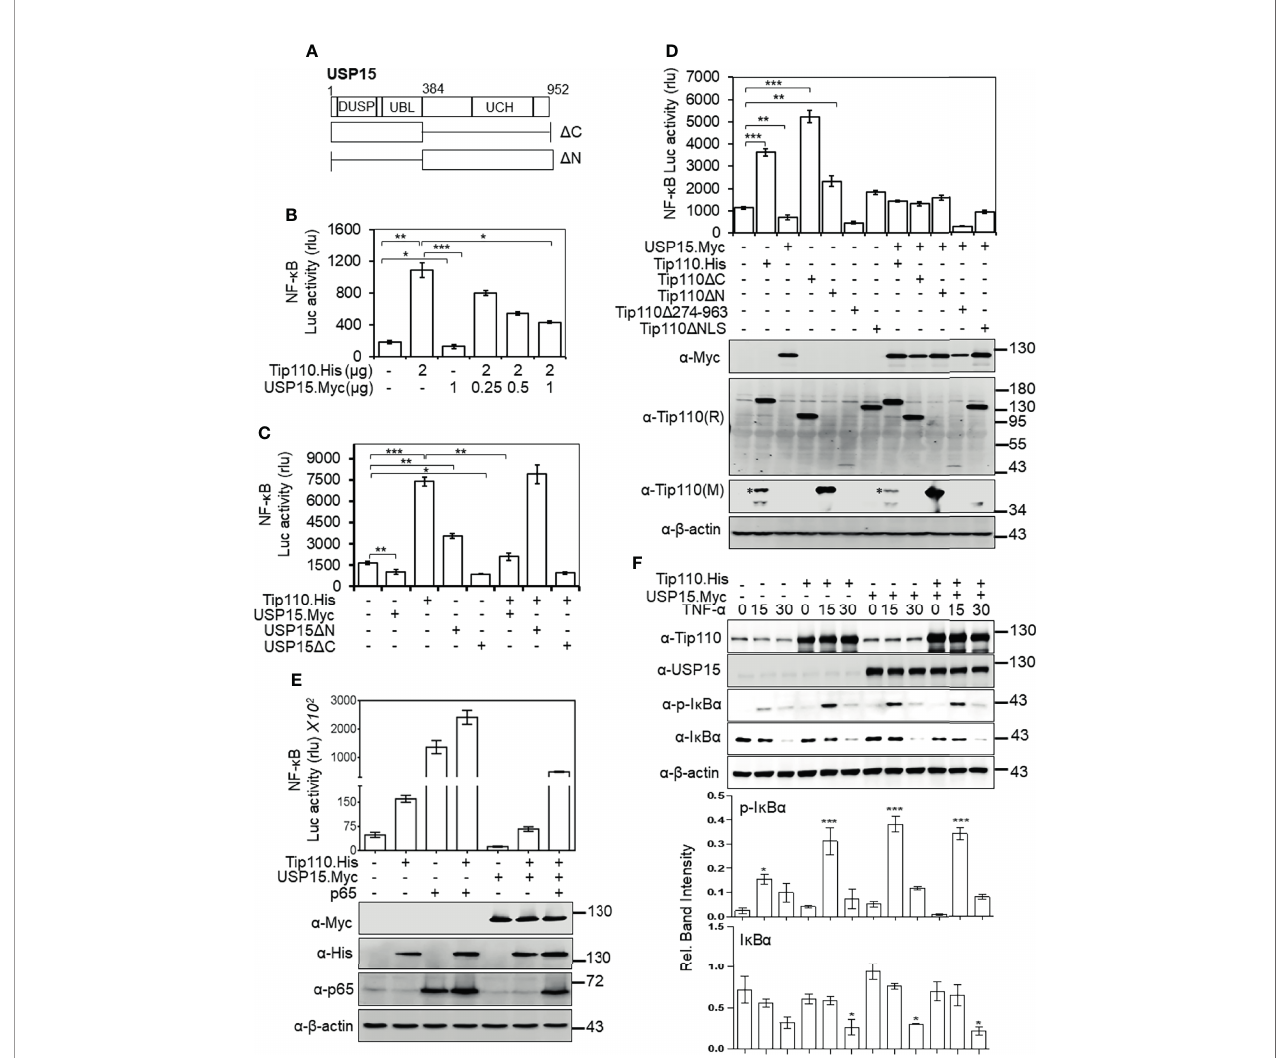
FIGURE 5 | USP15 abrogated Tip110-induced NF- k B activity by targeting I k B a . (A) Schematic of USP15 protein and its respective deletion mutants. USP15 contains three distinct domains: domain present in ubiquitin-speci fi c proteases (DUSP), ubiquitin-like domain (UBL), ubiquitin C-terminal hydrolase (UCH). (B) 293T were transfected with pGL3-NF- k B(3)-Luc, Tip110.His, and an increasing amount of USP15.Myc, cultured 48 hr, and harvested for the luciferase reporter gene assay. (C) 293T were transfected with pGL3-NF- k B(3)-Luc, Tip110.His, USP15.Myc, USP15 D N, or USP15 D C, cultured for 48 hr, and harvested for the